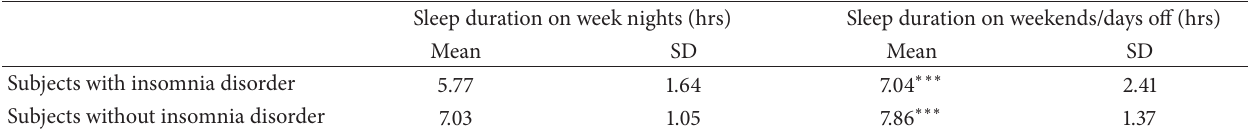
Table 3: Sleep duration on week nights and on weekends/days off in subjects with insomnia disorder ( 𝑛 = 118 ) and in subjects without insomnia disorder ( 𝑛 = 1005